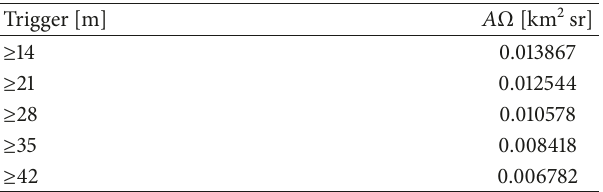
Table 6: Results of the effective area calculation for different trigger conditions. The trigger condition is the path length that a charged lepton or its highly boosted decay products travel along the 𝑥 - 𝑦 plane inside the detection volume of HAWC modelled as a rectangular